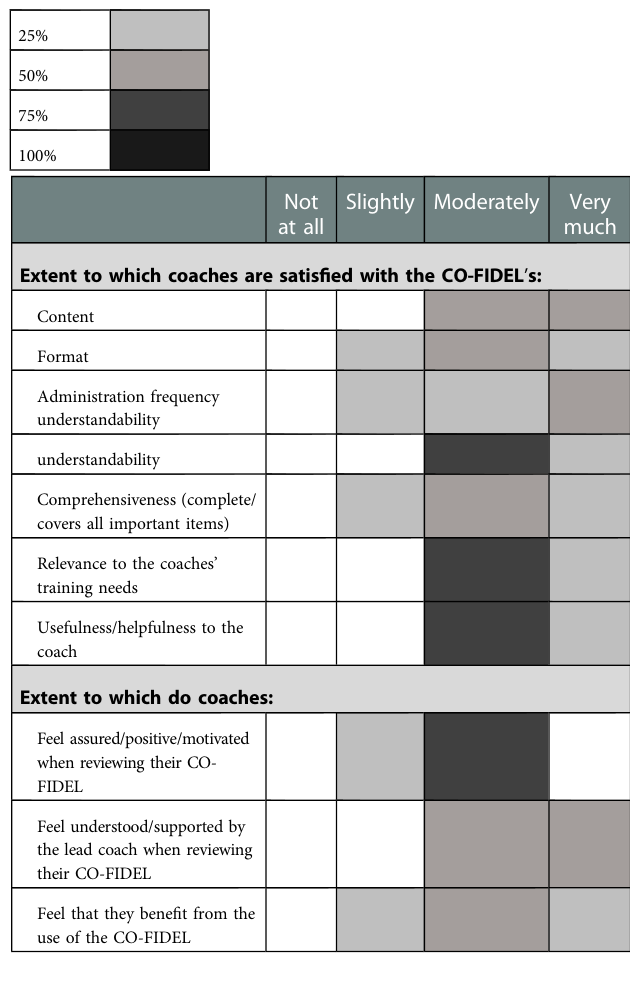
TABLE 3 Coaches responses: satisfaction and usefulness of